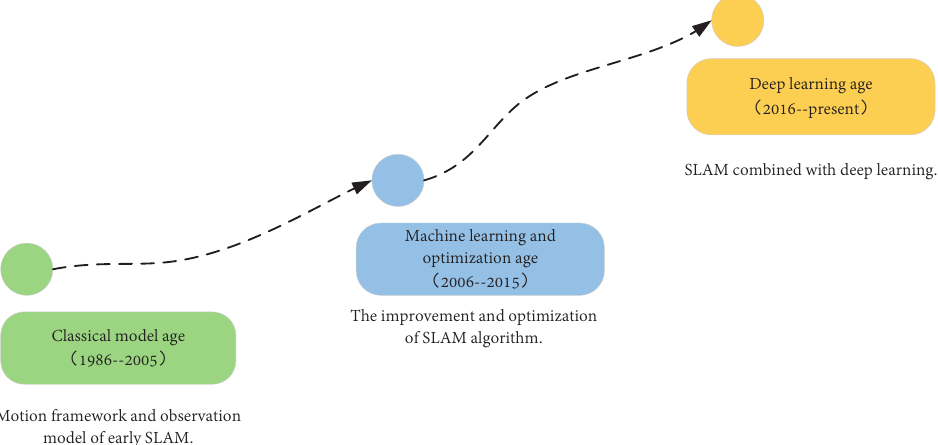
Figure 1. Different stages of SLAM development: classical stage, machine learning and optimization stage, and deep learning